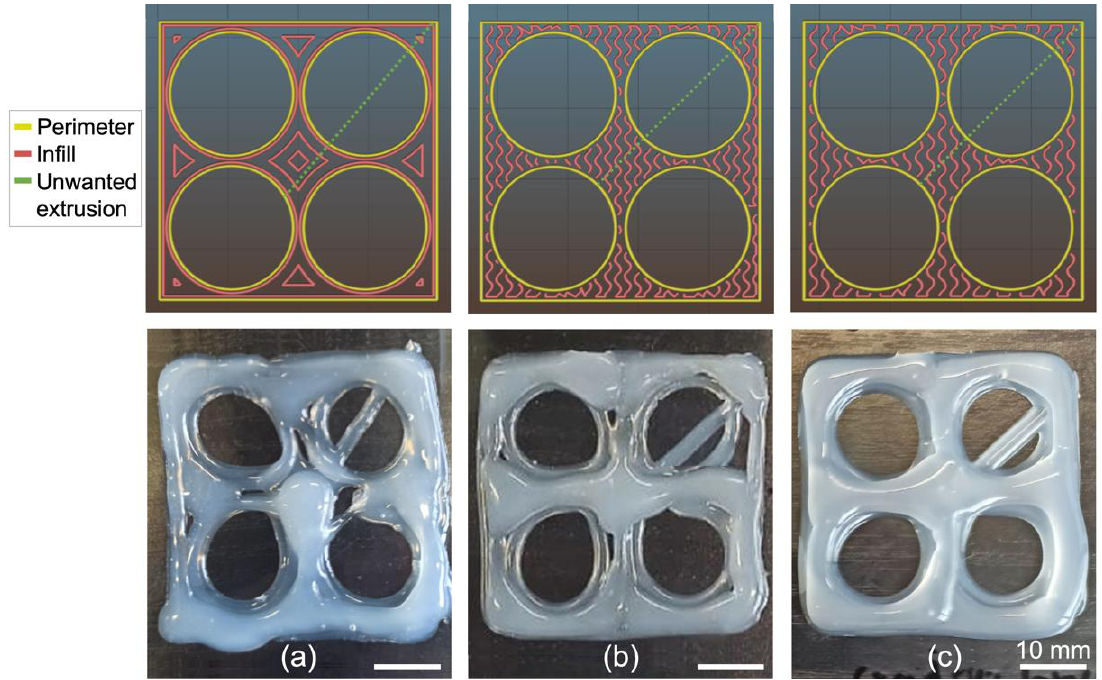
Figure 8. ( Top ) Printing paths generated in Slic3r. ( Bottom ) Corresponding prints of ( a ) a concentric pattern with 32% infill density and printing speed of 30 mm/s; ( b ) a gyroid pattern with 65% infill density and printing speed of 30 mm/s; and ( c ) a gyroid pattern with 56% infill density and printing speed of 10 mm/s. Silicone: Ecoflex 00-50. Needle diameter: 1.6 mm. Extrusion speed: 0 mm/s. Bed temperature: 90 °C.